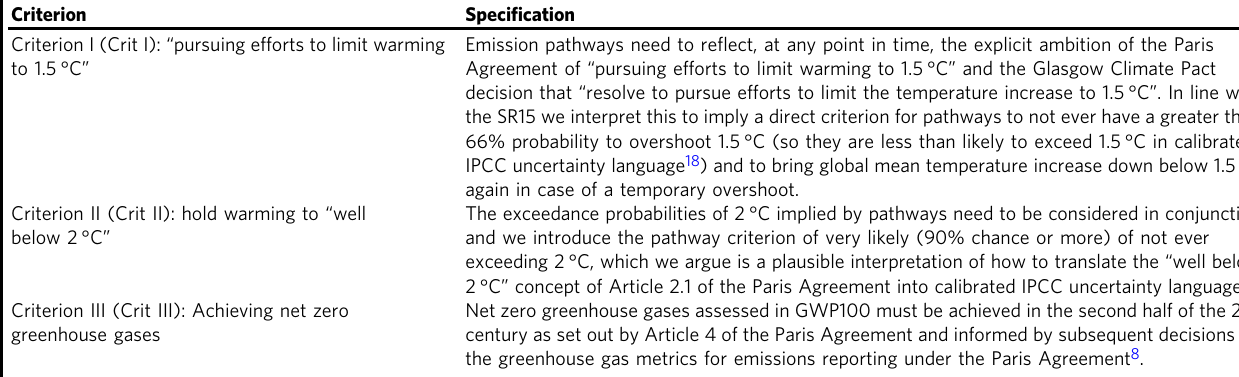
Table 2 Criteria for Paris agreement compatible